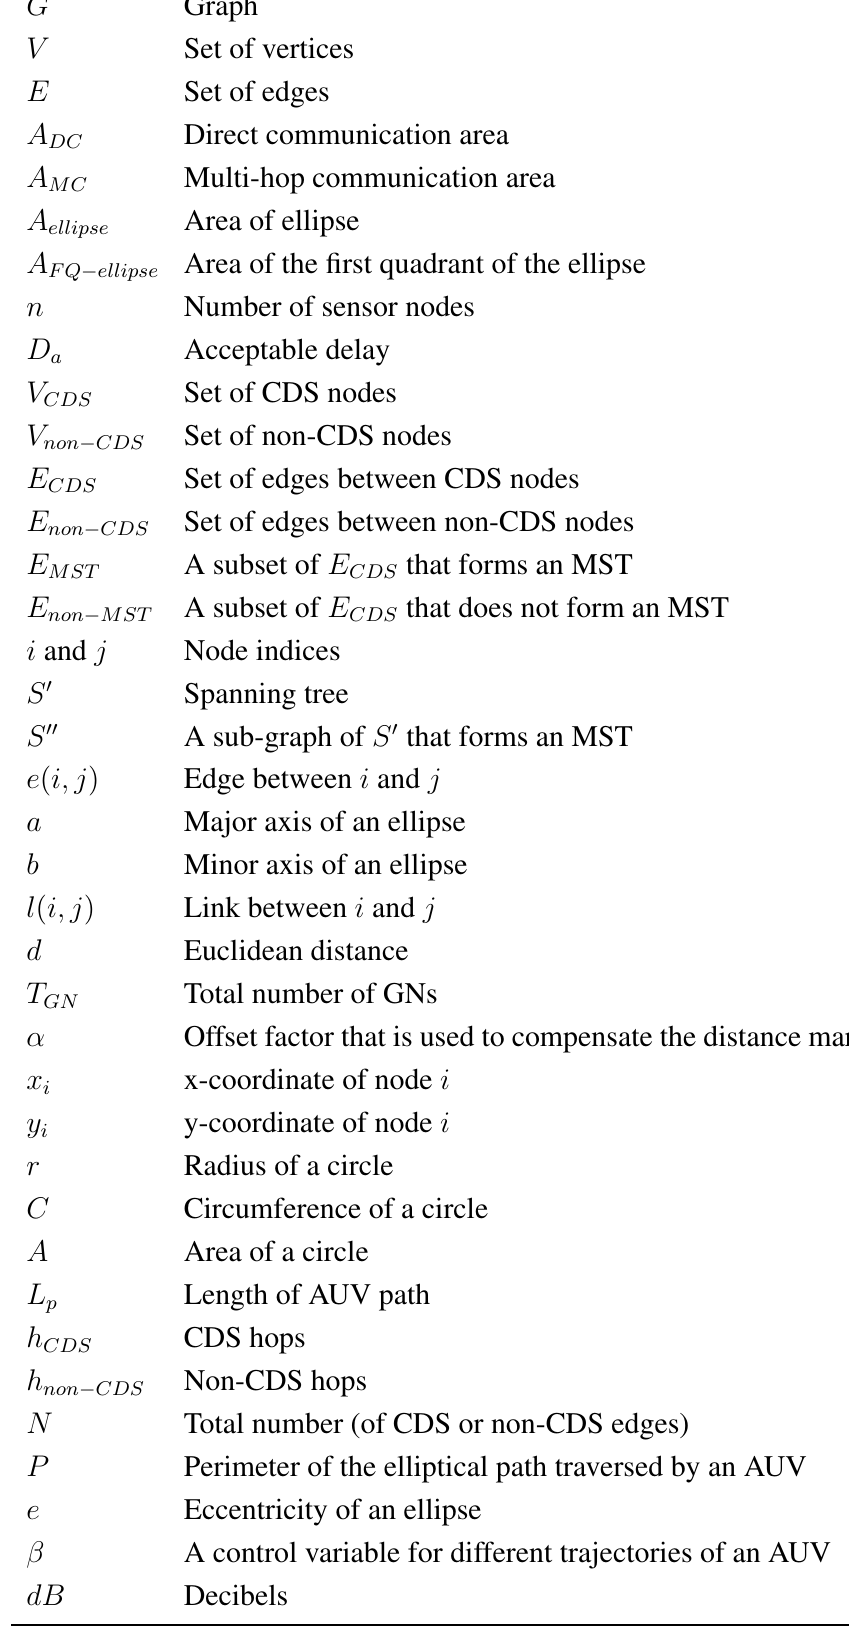
Table E2. List of